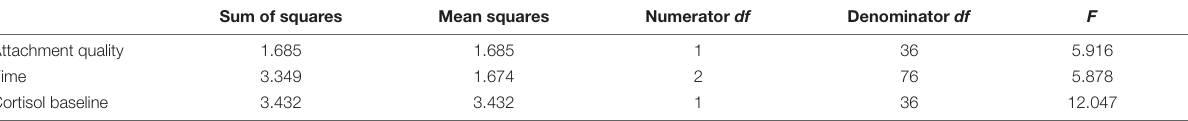
TABLE 5 | Mixed model on cortisol measures.